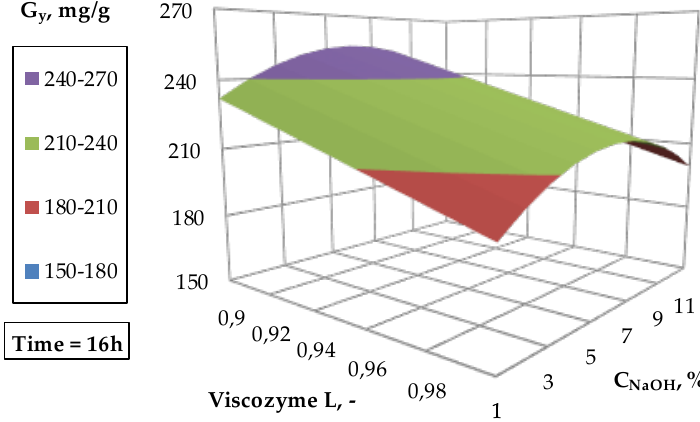
Figure 7. The surface response plots of the effects of NaOH concentration and Viscozyme L content on the glucose yield after 16 h of enzymatic hydrolysis.